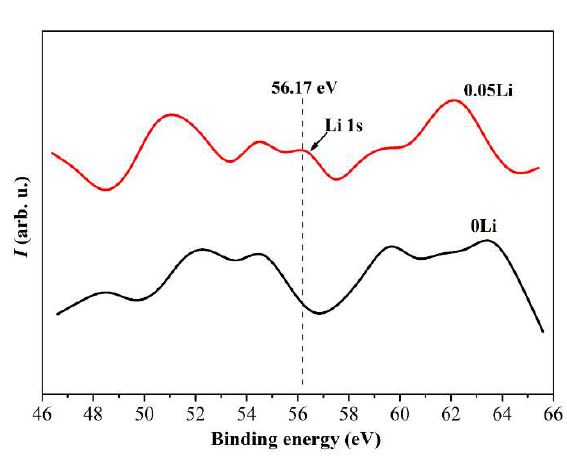
Figure A1. High resolution XPS spectra of Li 1s.